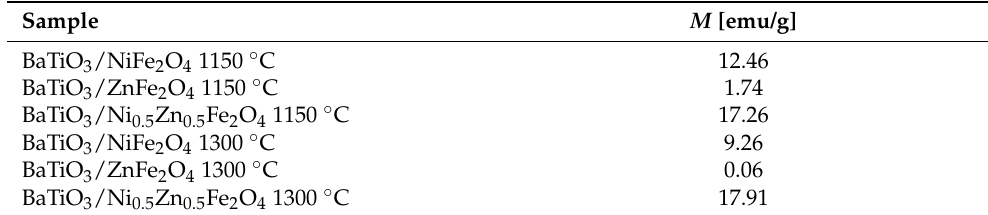
Figure 2. SEM and EDS layered images of non-sintered BaTiO 3 /NiFe 2 O 4 , BaTiO 3 /ZnFe 2 O 4 , and BaTiO 3 /Ni 0.5 Zn 0.5 Fe 2 O 4 samples (Ba-cyan; Zn-yellow; Ni-orange; Fe-magenta; Ti-blue; O-green). Table 2. Mass magnetization values of sintered samples at room